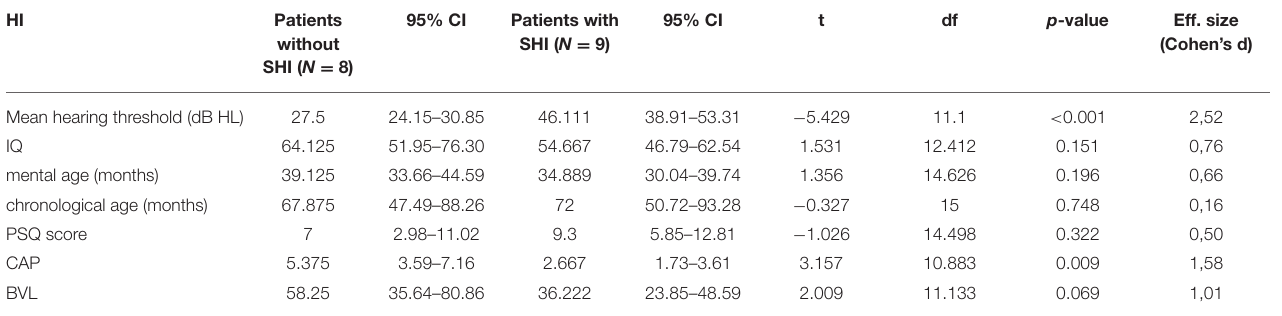
TABLE 1 | Mean mental age, chronological age, IQ, Pediatric Sleep Questionnaire (PSQ) scoring, auditory performance category (CAP), and receptive language (BVL) scoring in patients with and without an SHI, and the results of the non-parametric t -tests of the differences between the two subgroups.